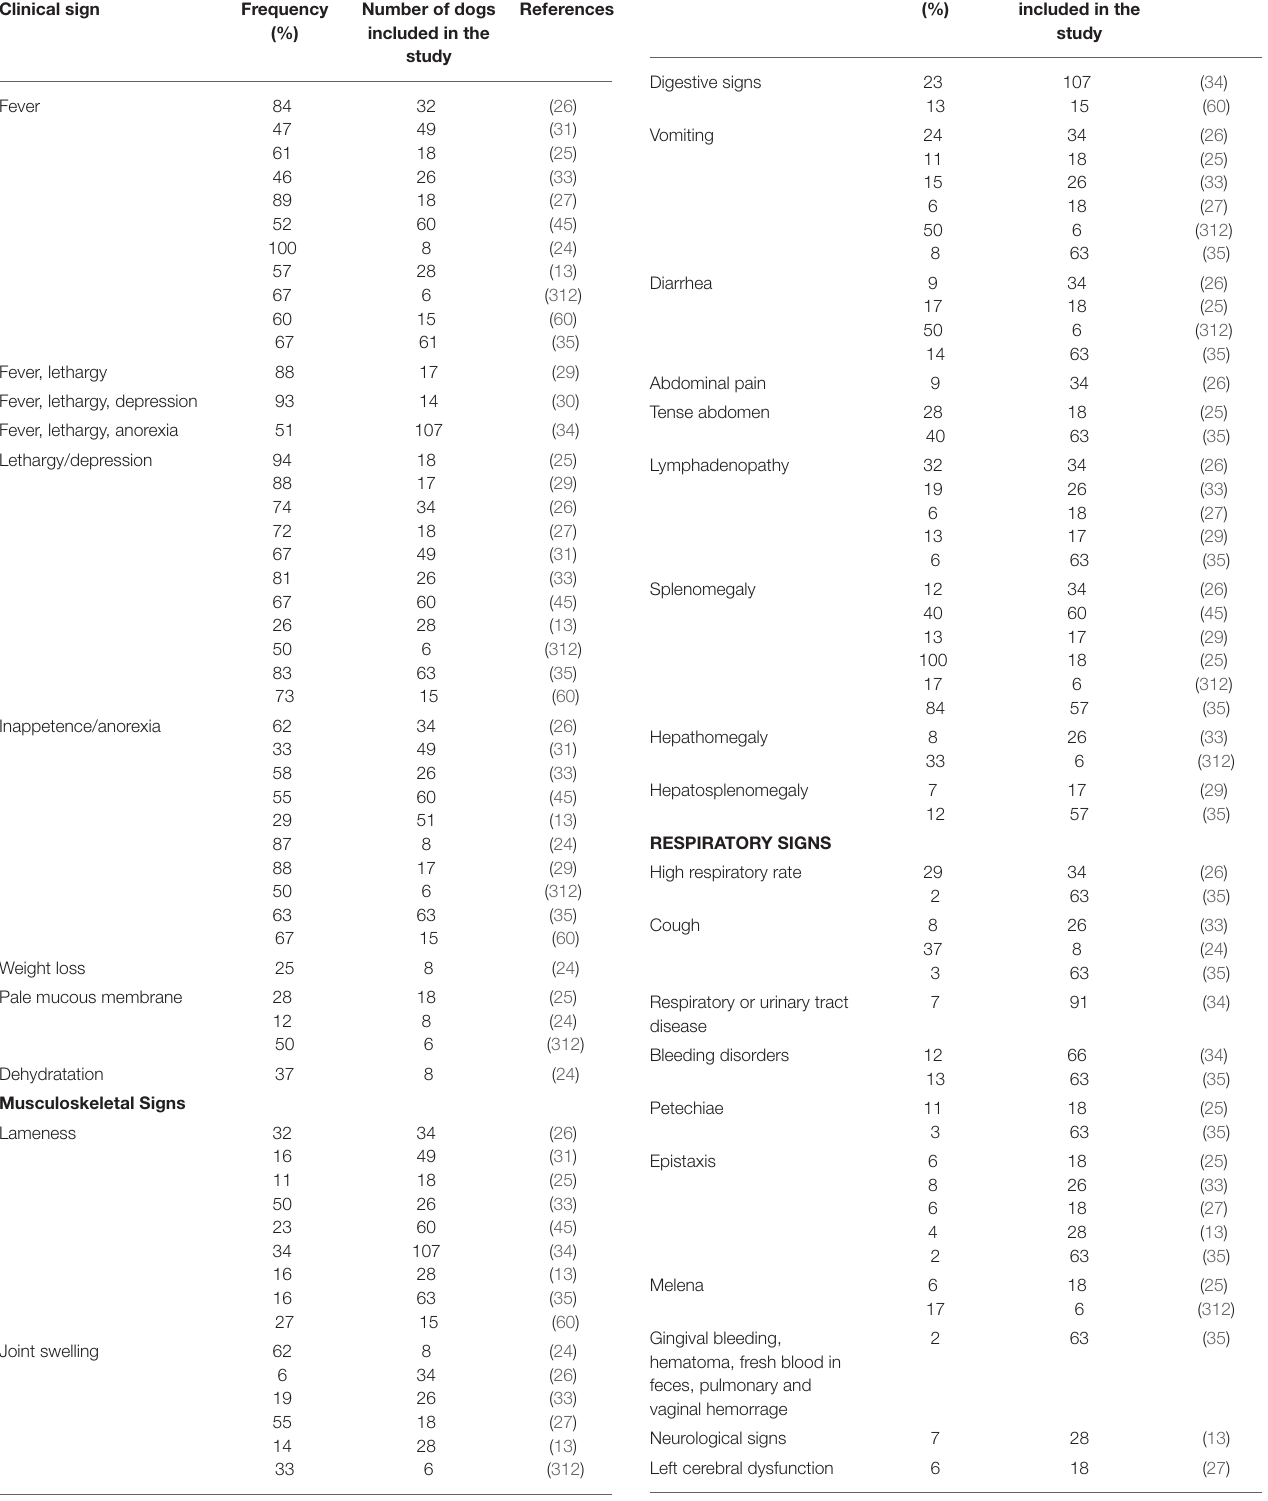
TABLE 2 | Clinical signs associated with canine granulocytic anaplasmosis after natural infection and corresponding frequency recorded in several studies. Clinical